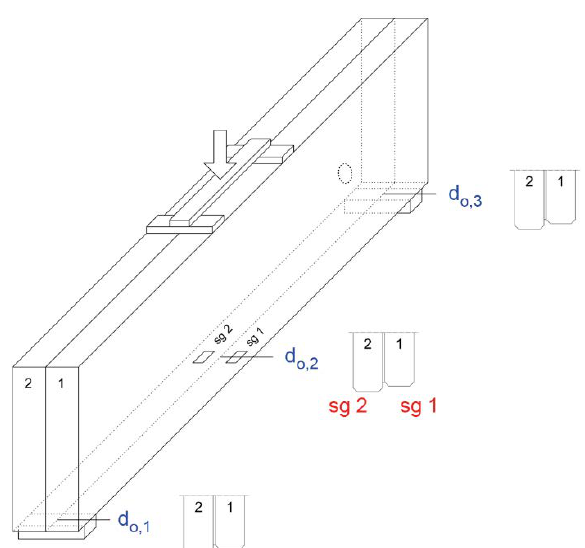
Fig. 7 Schematic structure of the specimen and the four-point bending test with d0 edge offset (blue) and sg stress on the strain gauges (red). The global minimum offset d o,2 in the centre is 0.1 mm and the maximum is 1.01 mm. Thus, all beams conform to EN ISO 12543-5, which specifies a maximum offset of 2 mm. The measurements show different types of the displacement. Almost all specimens have a constant negative or positive edge offset, which we define as the normal displacement.